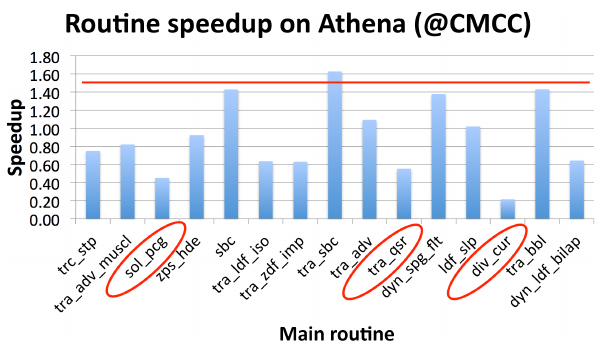
Figure 7. Analysis of scalability of the main routines on the iDat- aPlex cluster in terms of speedup. The speedup is evaluated as the ratio between the execution time on 1344 and 2048 cores. Hence the ideal scalability is reached with a speedup equal to 1.52. The red cir- cles indicate the routines whose speedup is far from the ideal value. The data, in this case, have been taken using the NEMO profiling support which provides information at a higher